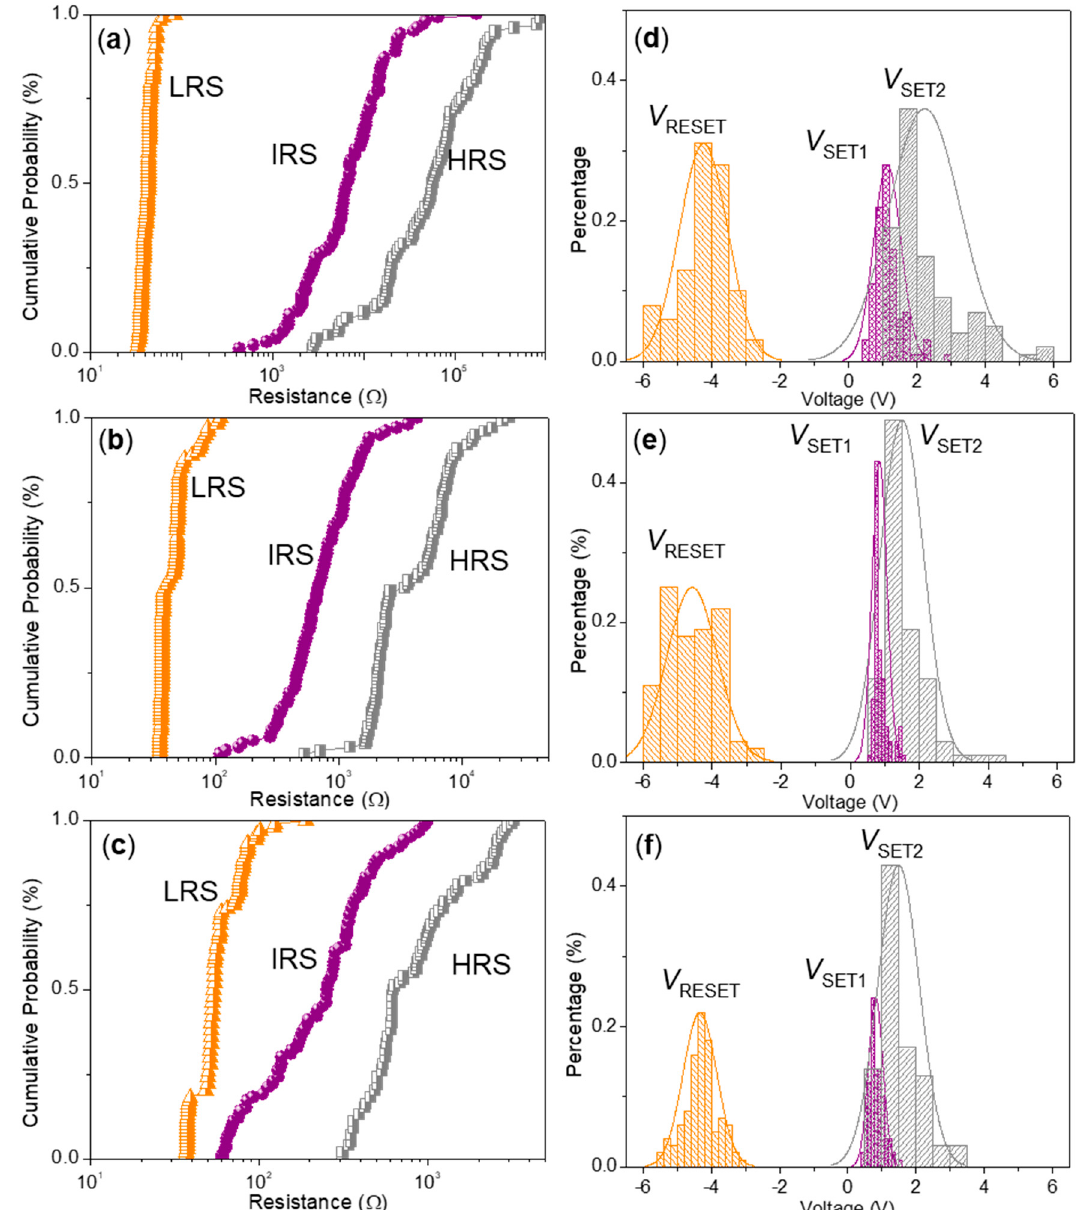
Figure 10. Cycle-to-cycle statistical distribution of ( a – c ) the resistance in HRS, IRS, and LRS ( R HLS , R ILS , and R LRS ), and ( d – f ) the set and reset voltage ( V SET1 , V SET2 , and V RESET ) for ITO / CS:GO / Ni with weight ratio of chemical component 2:1, 5:1, and 10:1 w / w , respectively. Table 2. Data analyses for ITO / CS:GO / Ni concerning the mean and deviation values of the resistance in HRS, IRS, and LRS ( R HLS , R ILS , and R LRS ). R HRS ( Ω ) R IRS ( Ω ) R LRS ( Ω ) Nanocomposites mean std